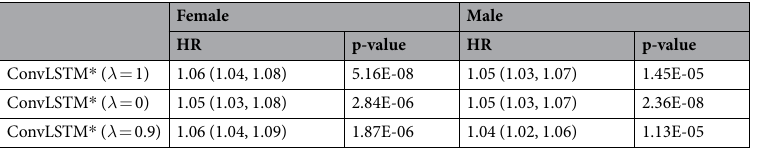
Table 5. Results of the Cox Proportional Hazard model (CoxPH) applied on the normalized biological age acceleration η = ( CA − BA )/ CA using separate models for female and male